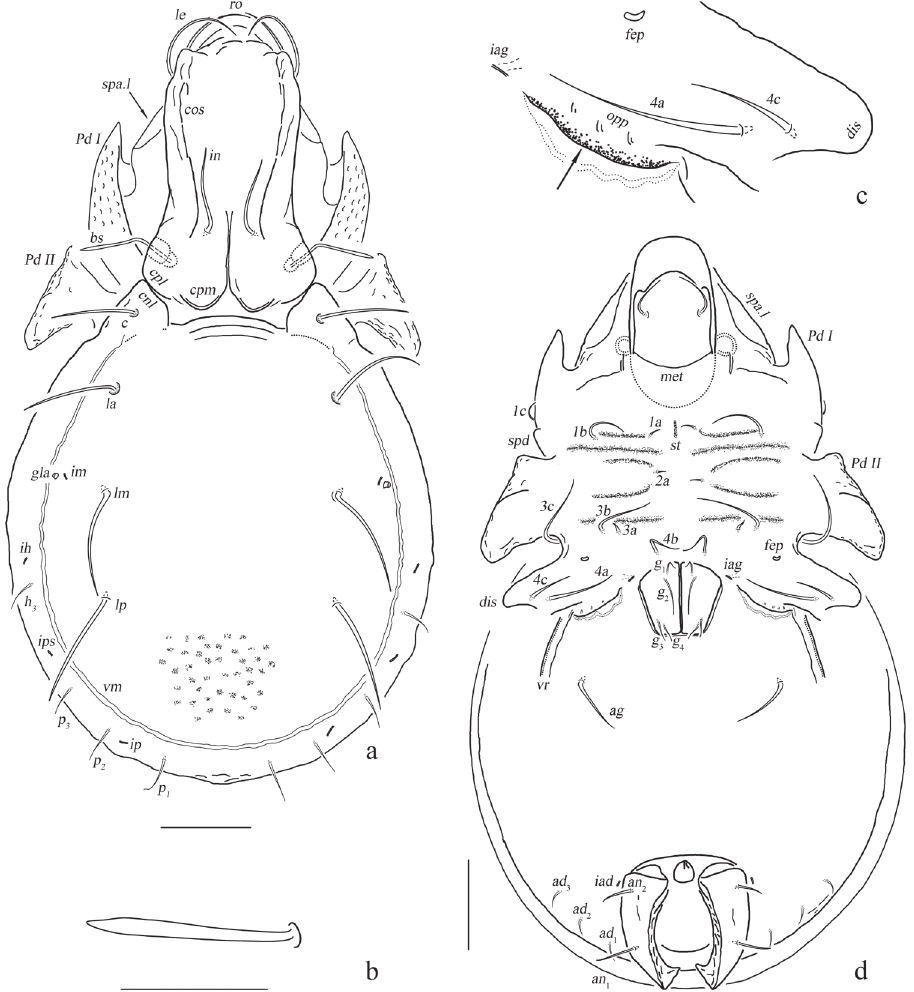
Figure 6. Eurostocepheus (Eurostocepheus) sinutus sp. nov., adult: a dorsal aspect (legs removed) b both- ridial seta c epimeron IV (left, part), showing ventral groove (arrow) d ventral aspect (legs and mouthparts removed). Abbreviations and notations explained in text. Scale bars: 200 μm ( a, d ); 100 μm ( b